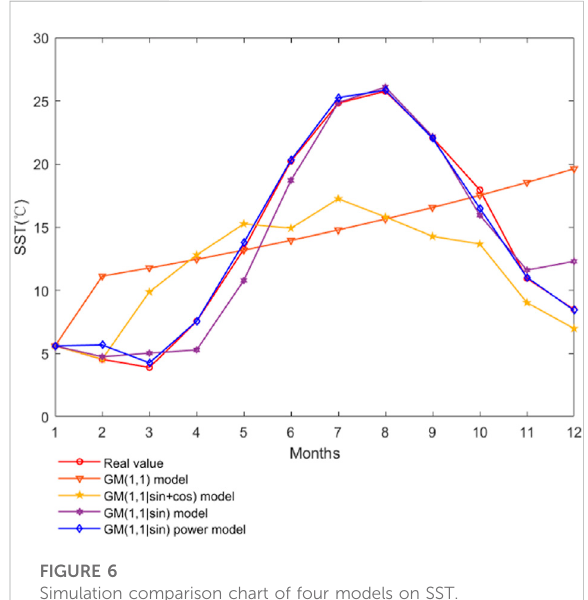
FIGURE 6 Simulation comparison chart of four models on SST.